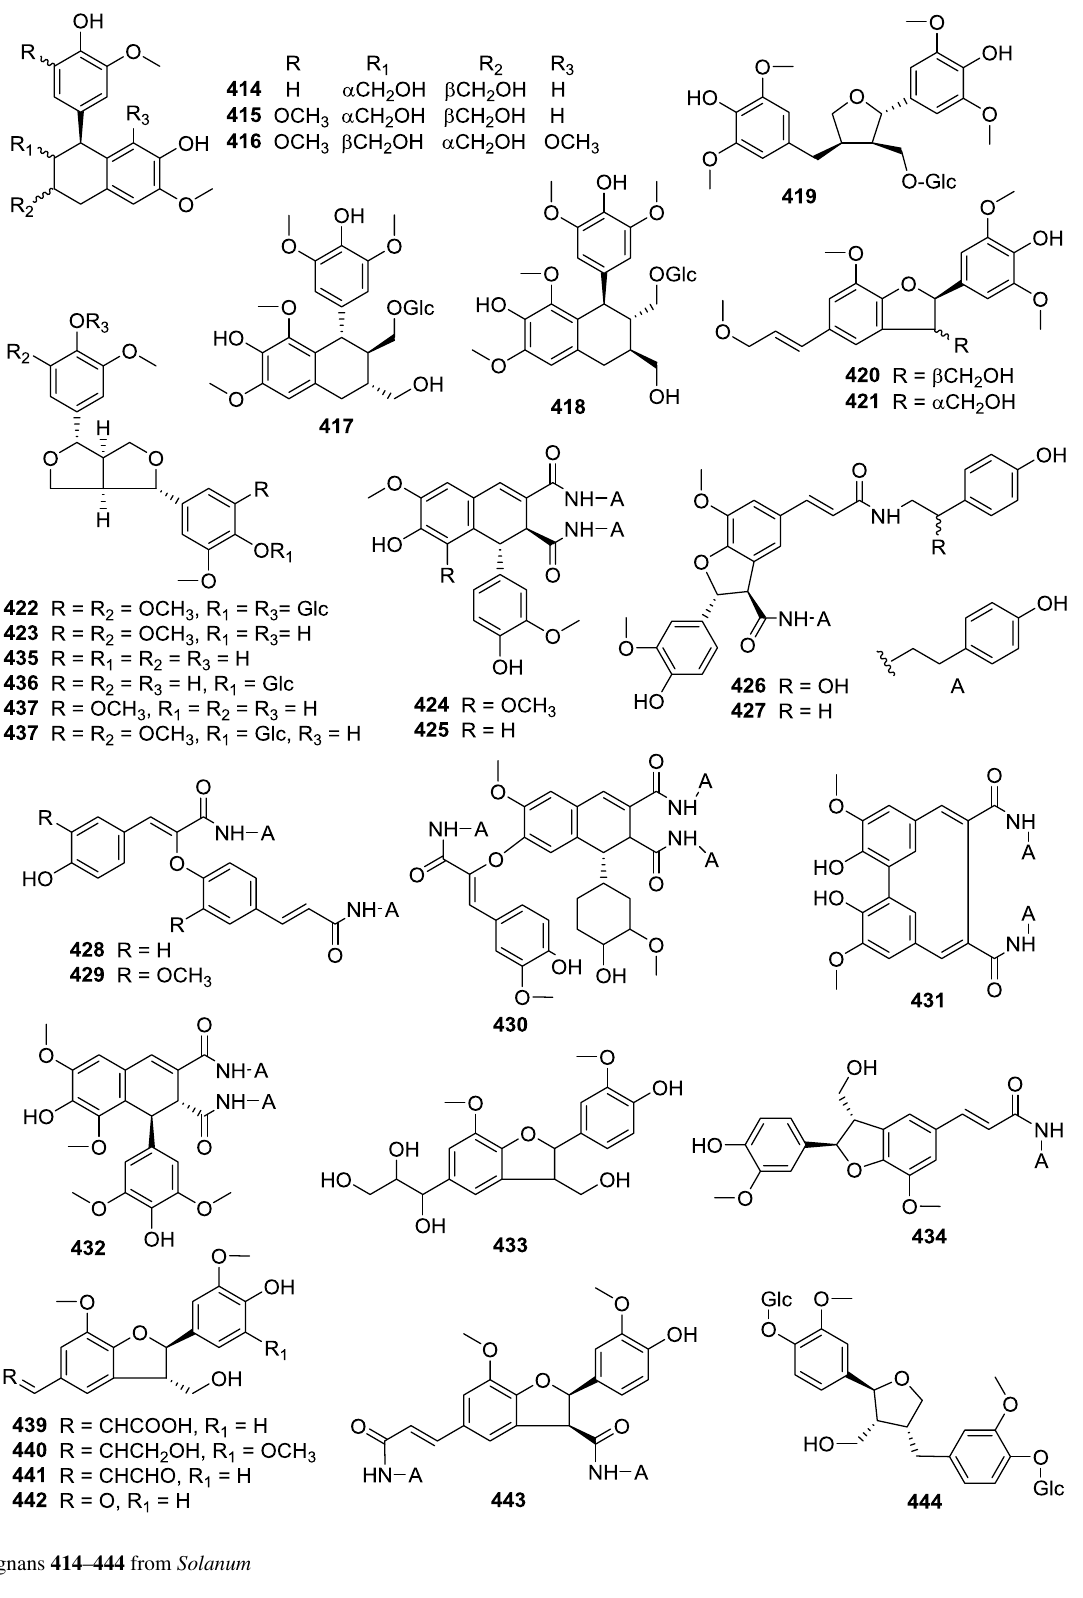
Fig. 9 Lignans 414 – 444 from